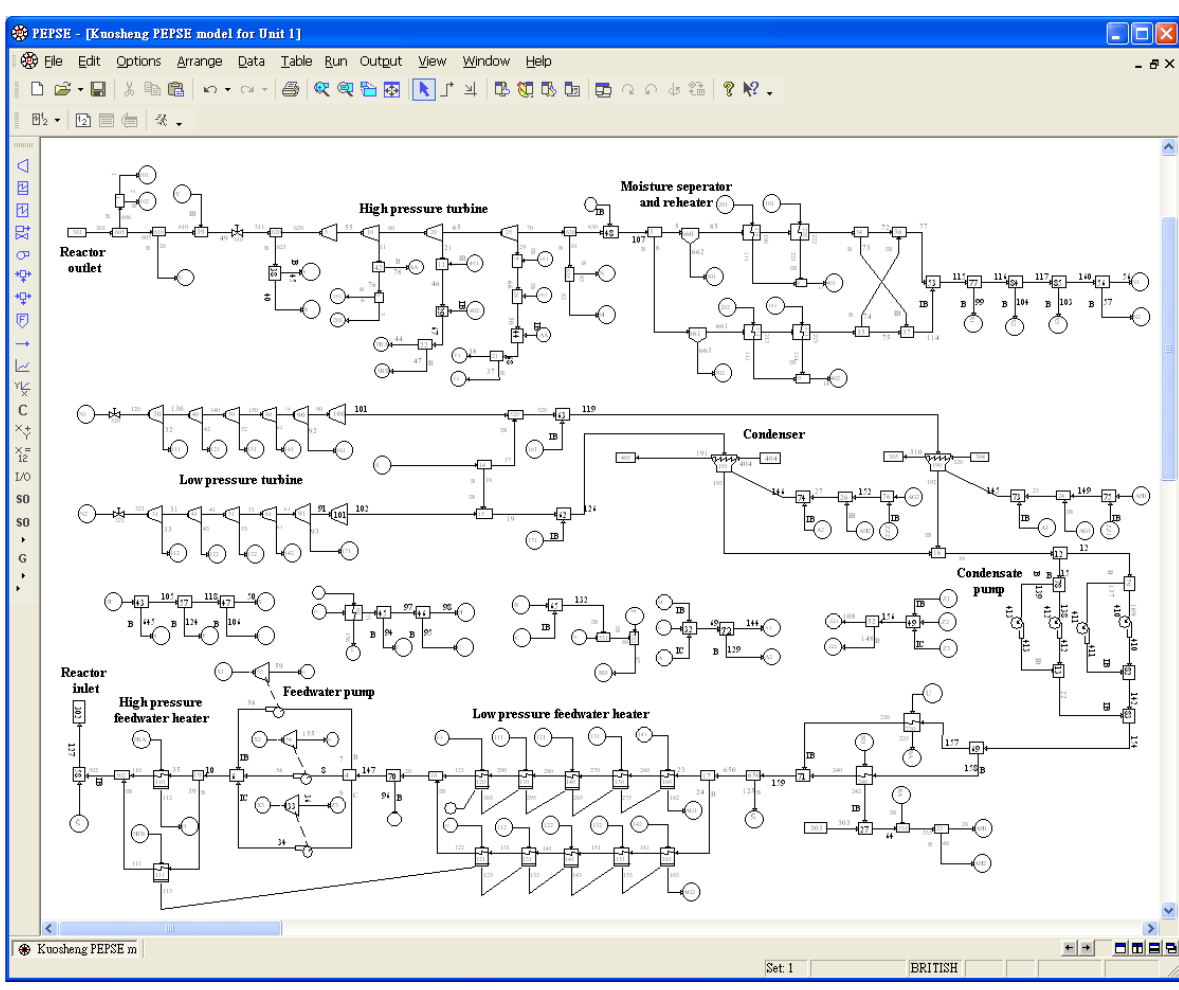
Figure 2. PEPSE ® turbine cycle model for Unit 1 of the Kuosheng